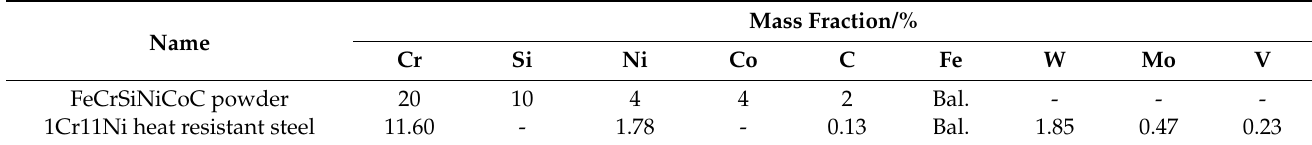
Table 1. Nominal chemical composition of FeCrSiNiCoC powder and 1Cr11Ni heat resistant steel